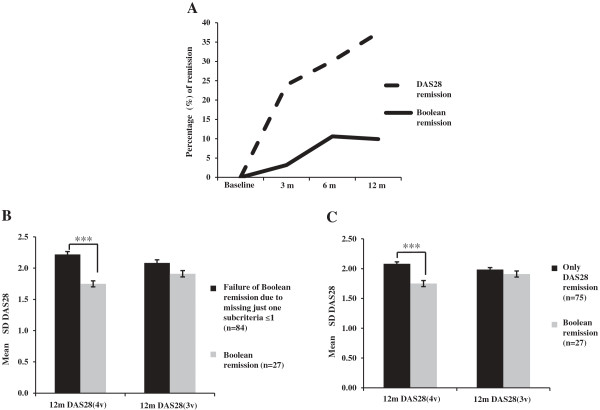
Characteristics of disease activity score based on 28 joints and Boolean remission groups. (A) Percentage of patients in disease activity score based on 28 joints (DAS28) remission versus Boolean remission. 3 m, 6 m and 12 m: 3 months, 6 months and 12 months post tumour necrosis factor inhibitor therapy. (B) The 1-year four-variable disease activity score (DAS28(4v)) was higher for patients who failed Boolean remission due to just one subcriterion being ≤1, but disease activity did not differ from Boolean remission calculated with the three-variable formula (DAS28(3v)). This explains that significant differences in disease activity resulted mainly in higher patient global health. (C) The DAS28(4v) was higher in the only DAS28 remission group, but disease activity did not differ from Boolean remission patients calculating with the DAS28(3v). This explains that significant differences in disease activity resulted mainly in higher patient global health. ***P <0.0001. SD, standard deviation.